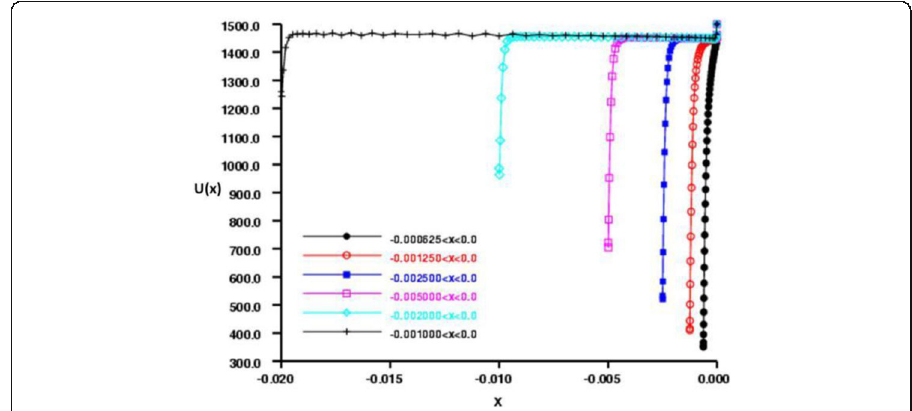
Fig. 5 Gauss-Lobatto quadrature across a finite Jump